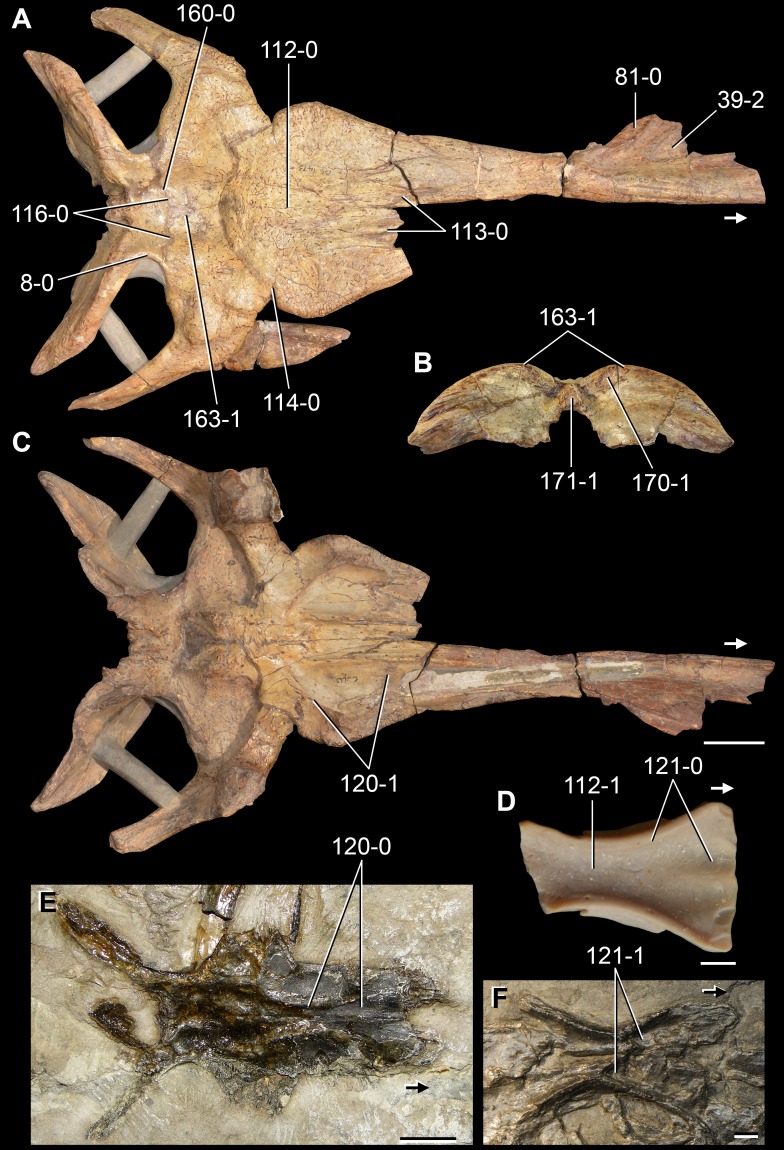
Partial skull roofs (A–C, E) and pair of frontals (D, F) of Triassic saurians in (A) dorsal, (B) posterior, and (C–F) ventral views.(A–C) Erythrosuchus africanus (NMQR 1473); (D) Planocephalosaurus robinsonae (NHMUK PV R9975); (E) Tasmaniosaurus triassicus (UTGD 54655); and (F) Macrocnemus bassanii (PIMUZ T2472). Numbers indicate character-states scored in the data matrix and the arrows indicate anterior direction. Scale bars equal 5 cm in (A–C), 1 mm in (D), 1 cm in (E), and 2 mm in (F).